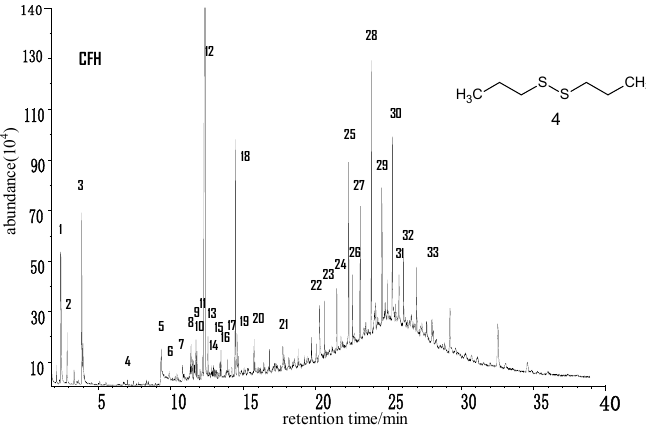
Figure 5. Total ion chromatogram (TIC) of the THF extract of CFH coal samples.